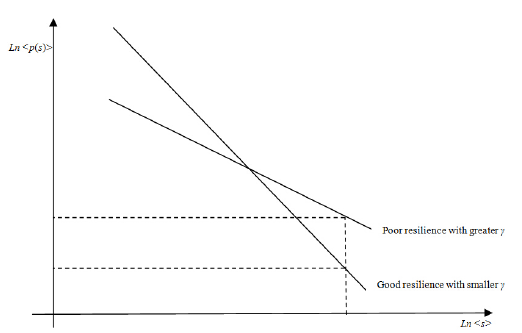
Figure 9. The resilience based on avalanche size distribution.